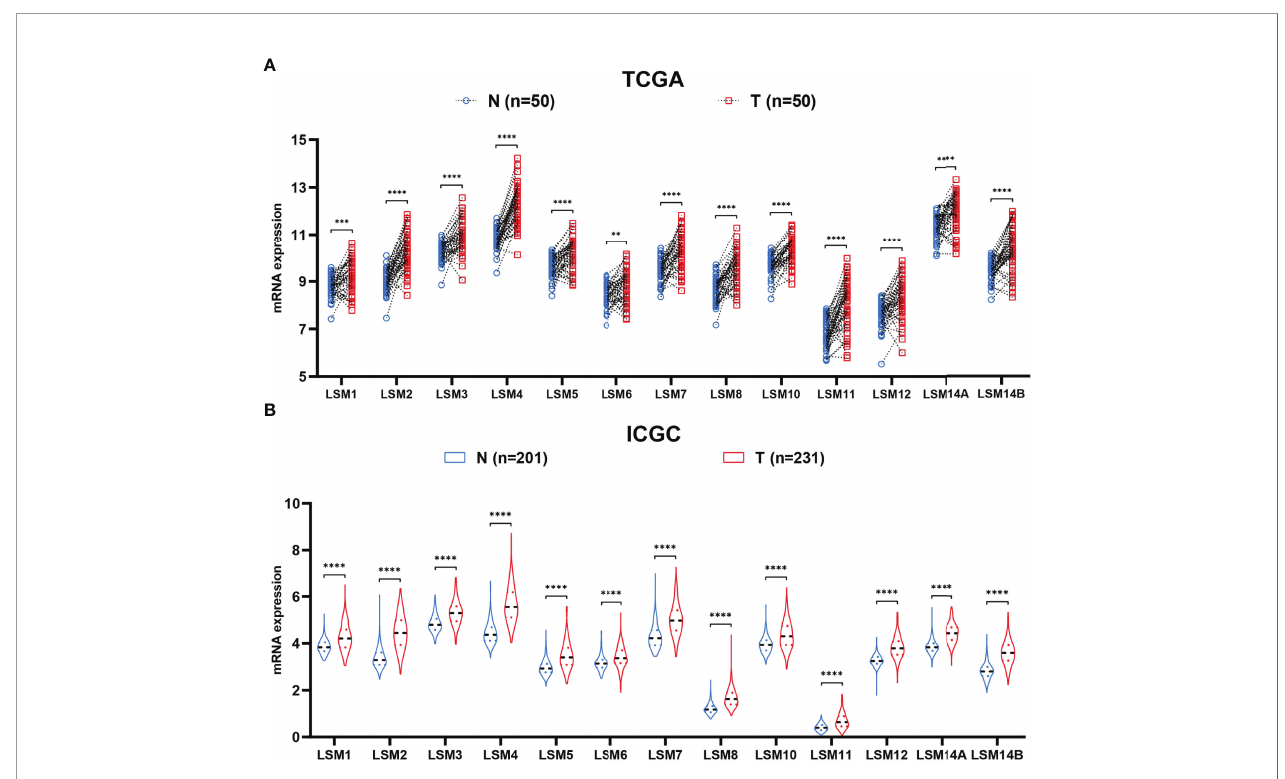
FIGURE 1 | Differential expression analysis of LSM family members. (A) LSM family members were signi fi cantly upregulated in HCC tissues compared with that in the adjacent non-tumor tissues in the TCGA HCC cohort. (B) LSM family members were signi fi cantly up-regulated in HCC tissues compared with that in the adjacent non-tumor tissues in the ICGC HCC cohort. LSM, Smith-like (LSM) family members; HCC, hepatocellular carcinoma; TCGA, the Cancer Genome Atlas; ICGC, the International Cancer Genome Consortium. **P-value <0.01; ***P-value <0.001; ****P-value